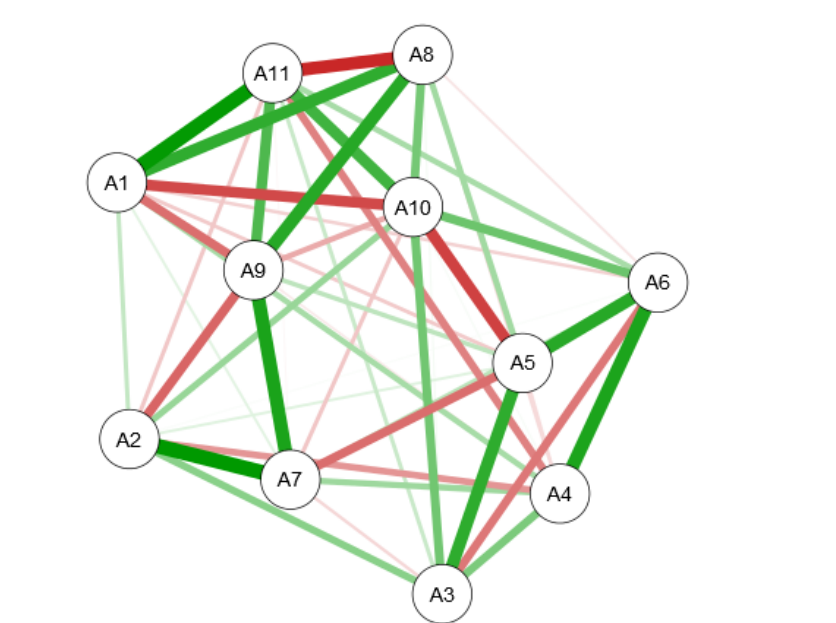
Figure 4 The acceptability network model of respondents who had received mental health intervention by